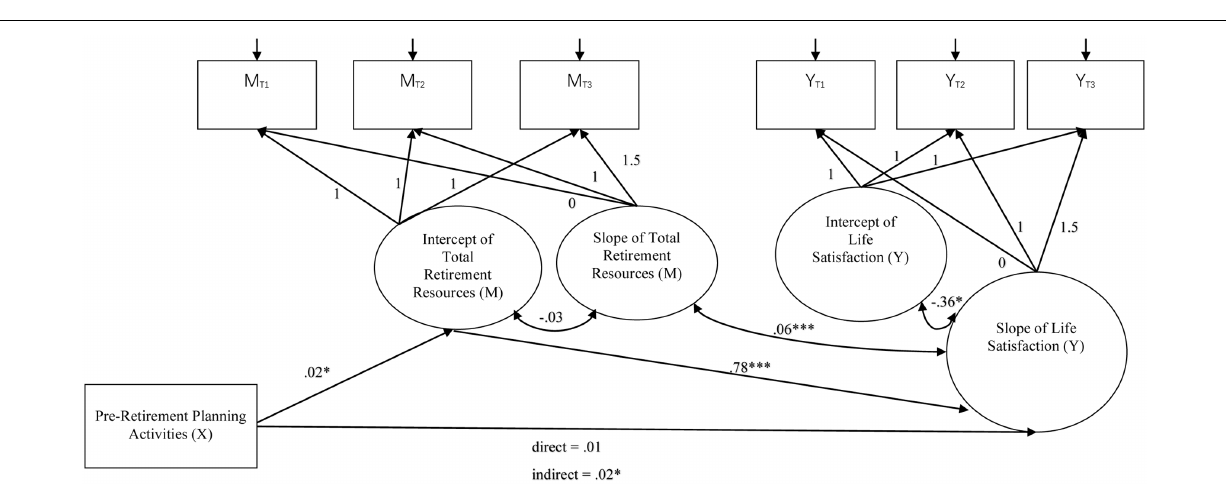
FIGURE 3 | The latent growth mediation model on life satisfaction. X denotes the independent variable; M denotes the mediator; and Y denotes the dependent variable. The model fit indices are: CFI = 0.921; RMSEA = 0.146; AIC = 998.979; BIC = 1072.017. Age and gender were controlled in the model as covariates. ∗ p < 0.05; ∗∗ p < 0.01; ∗∗∗ p <